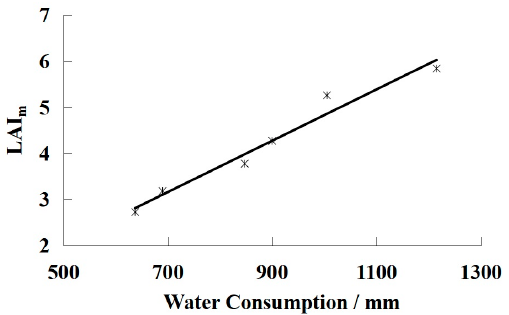
Figure 6. The relationship between leaf area index (LAI m ) and water consumption.